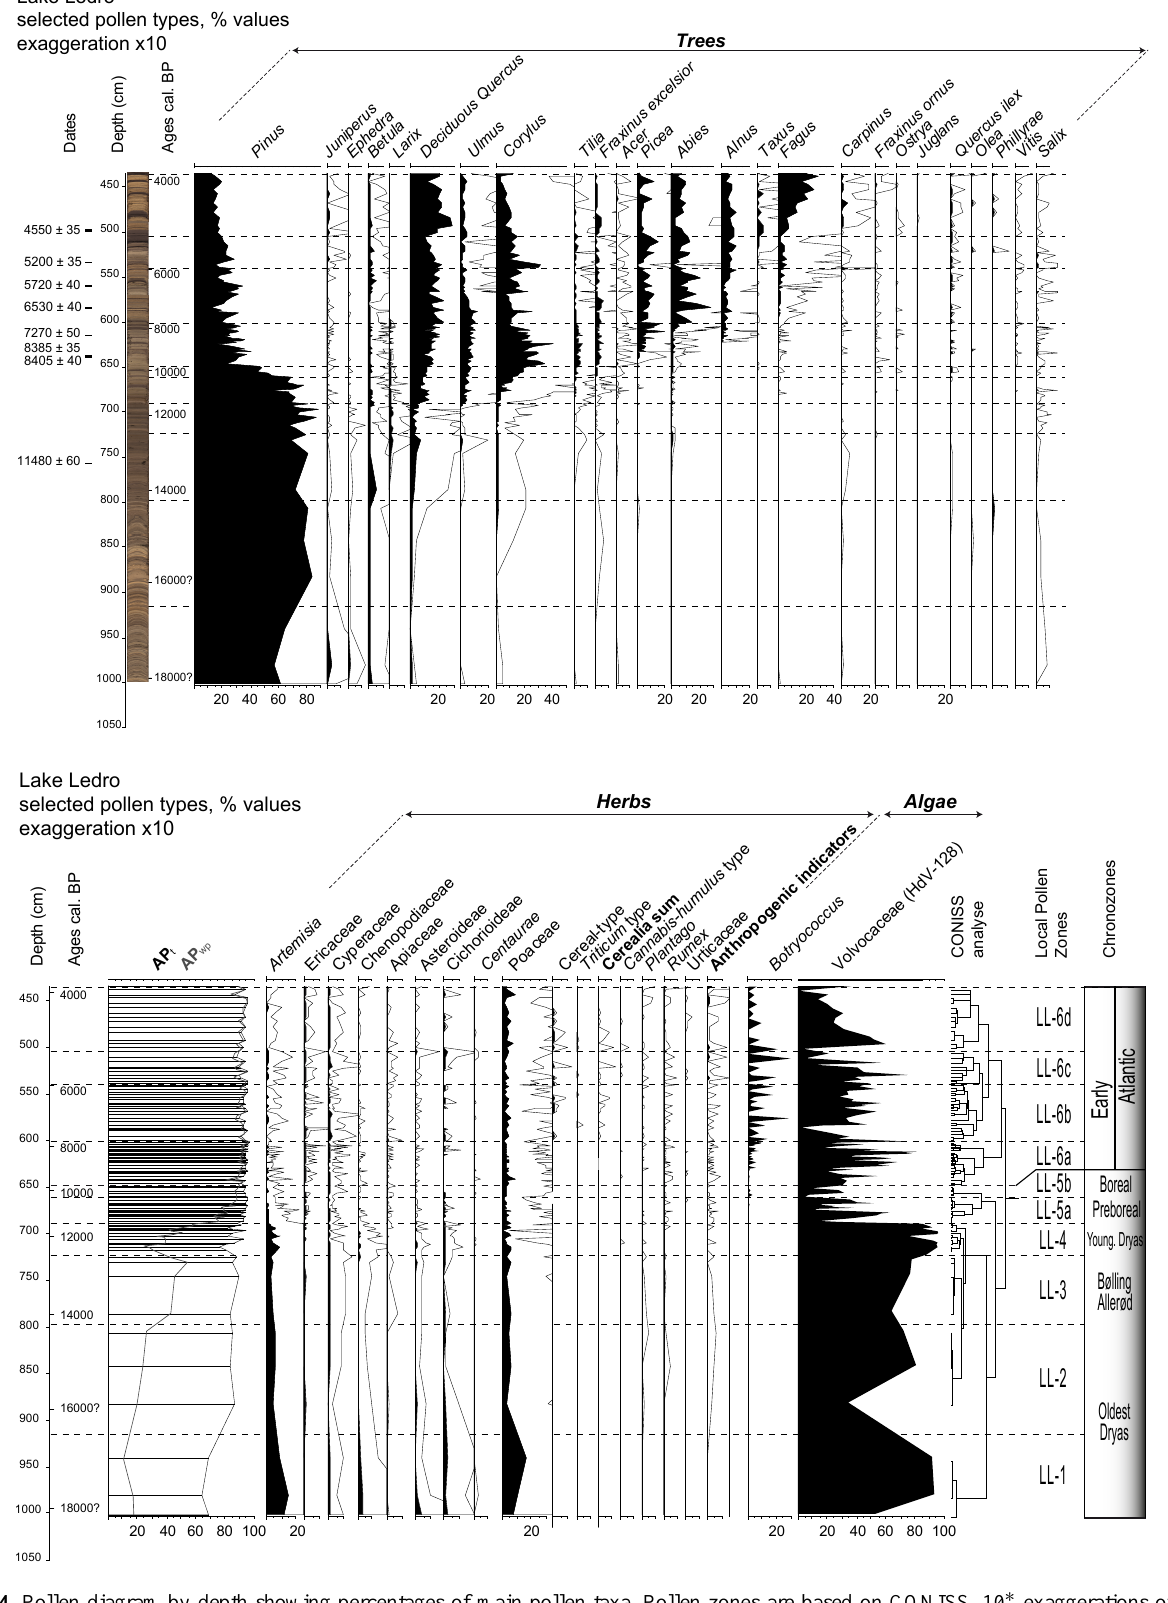
Fig. 4. Pollen diagram by depth showing percentages of main pollen taxa. Pollen zones are based on CONISS. 10 ∗ exaggerations of the pollen curves are also